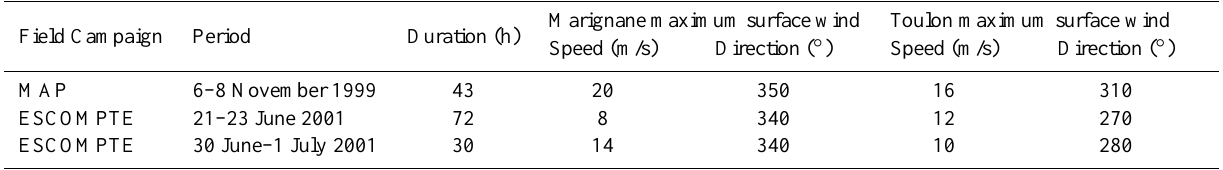
Table 1. Characteristics of the three Mistral events reported in the present study. Field